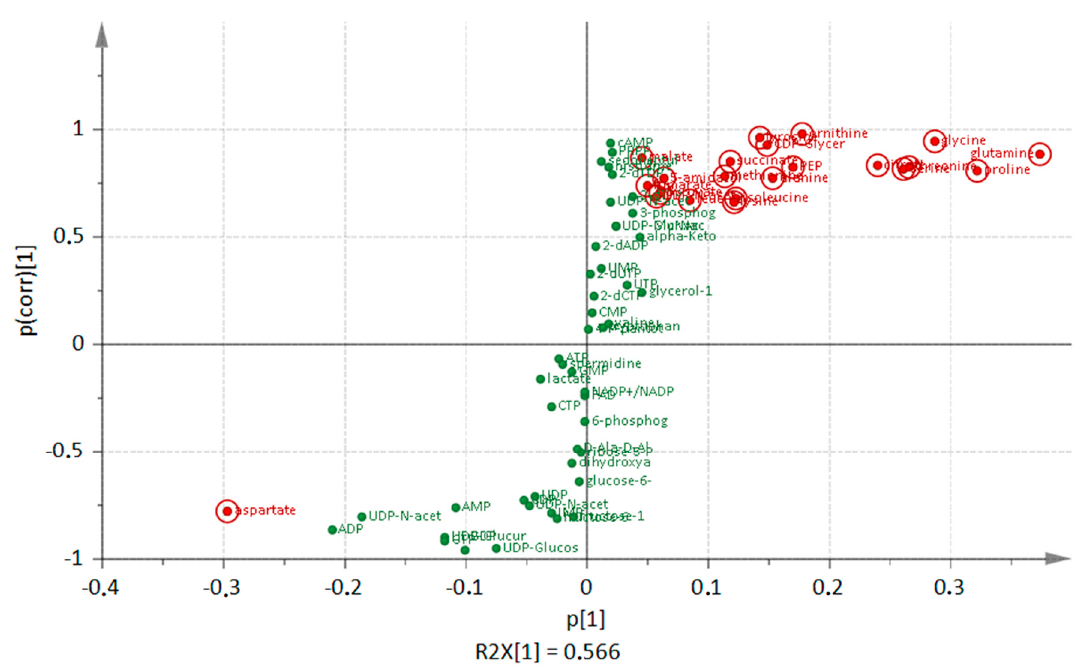
Figure 3. Figure 3. S-plot from Orthogonal Projections to Latent Structures Discriminant Analysis (OPLS-DA) loadings. The most increased and decreased metabolites (green dots) of the clpP mutant in comparison to the wild type in the late stationary phase are highlighted in